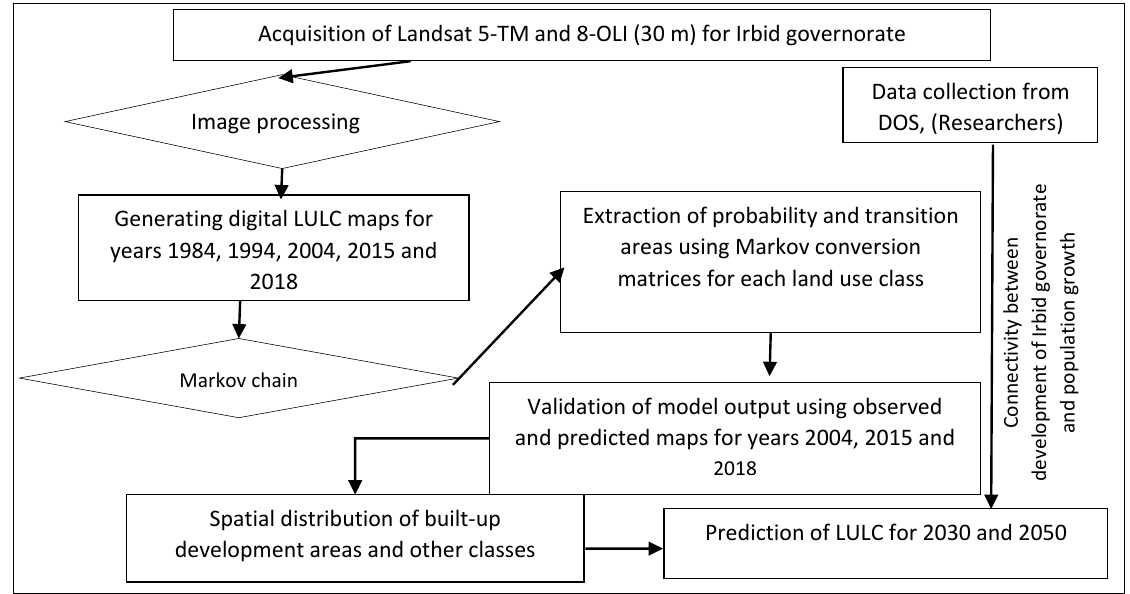
Acquisition of Landsat 5-TM and 8-OLI (30 m) for Irbid governorate